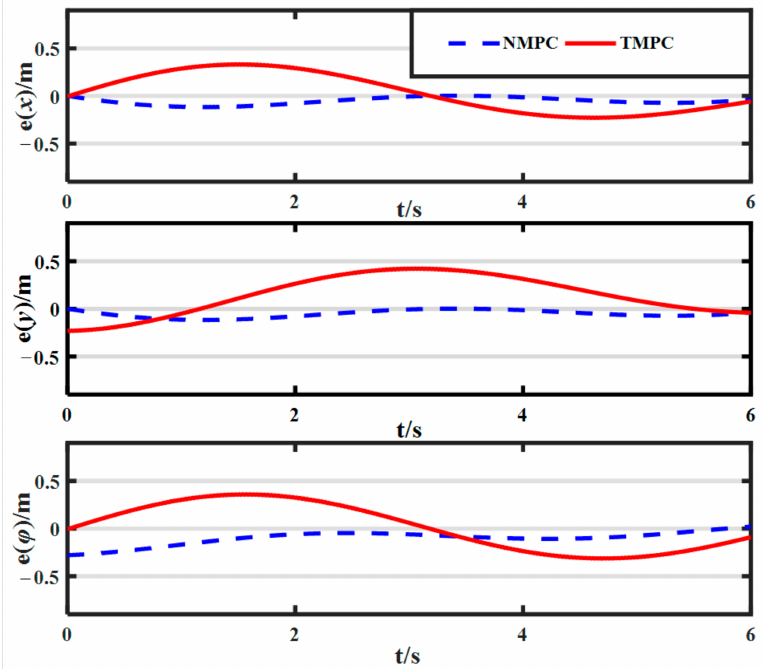
Figure 10. The tracking errors of x , y , and ϕ under the